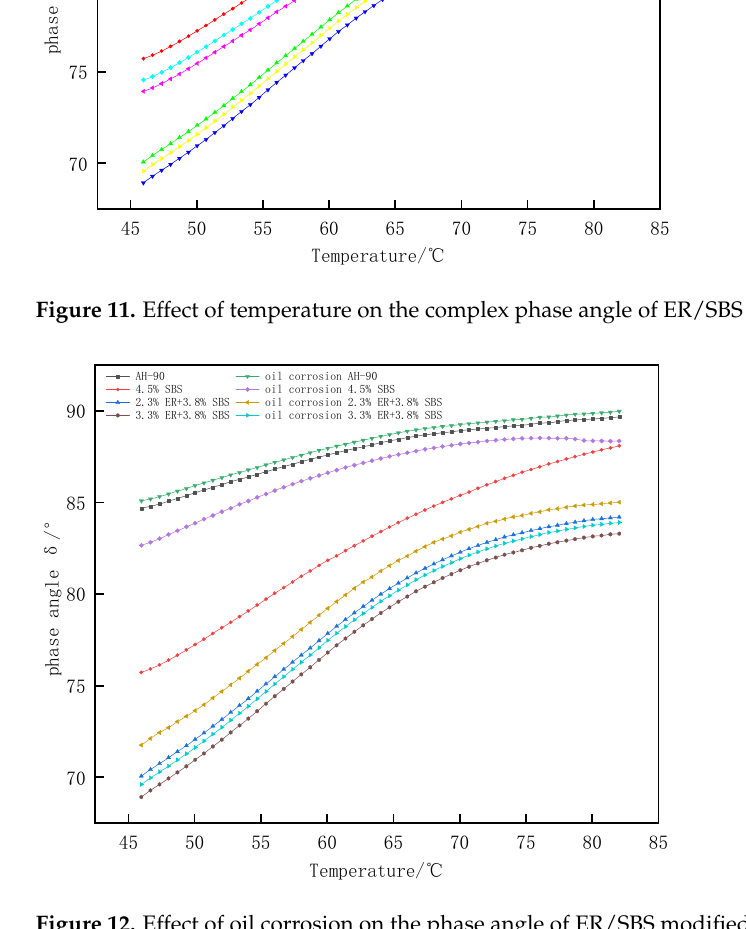
Figure 12. Effect of oil corrosion on the phase angle of ER/SBS modified bitumen.